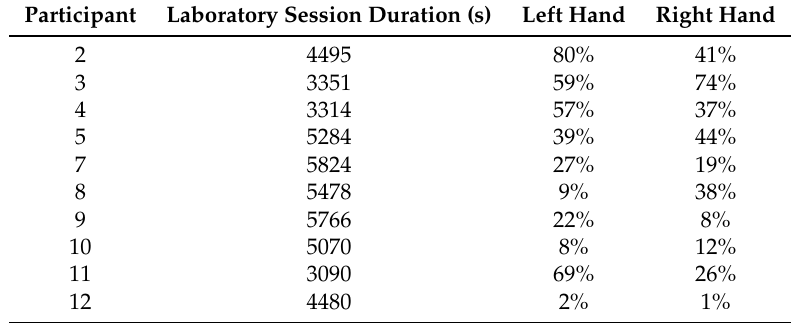
Table 1. Laboratory session duration (s) and percentage of tremor time for left and right hands.